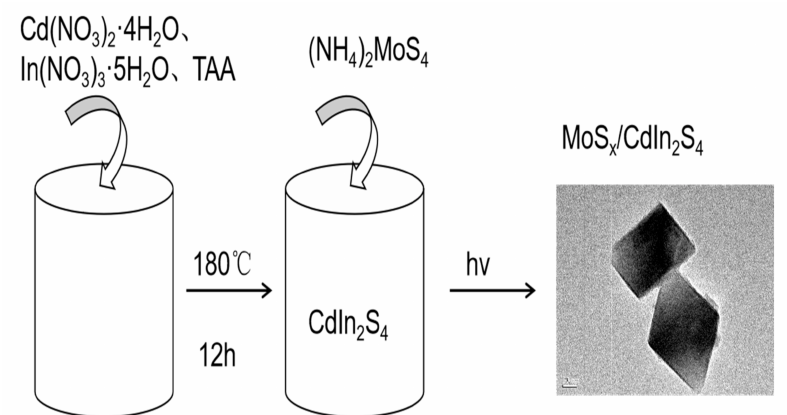
Figure 1. The synthesis method of MoS x / CdIn 2 S 4 . MoS x / CdIn 2 S 4 composites were prepared by a